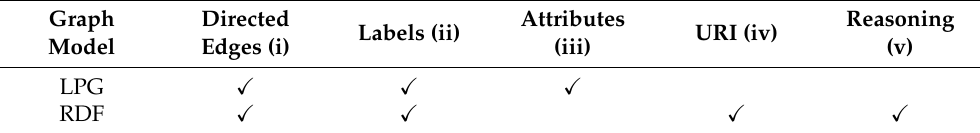
Table 1. A comparison between the two graph